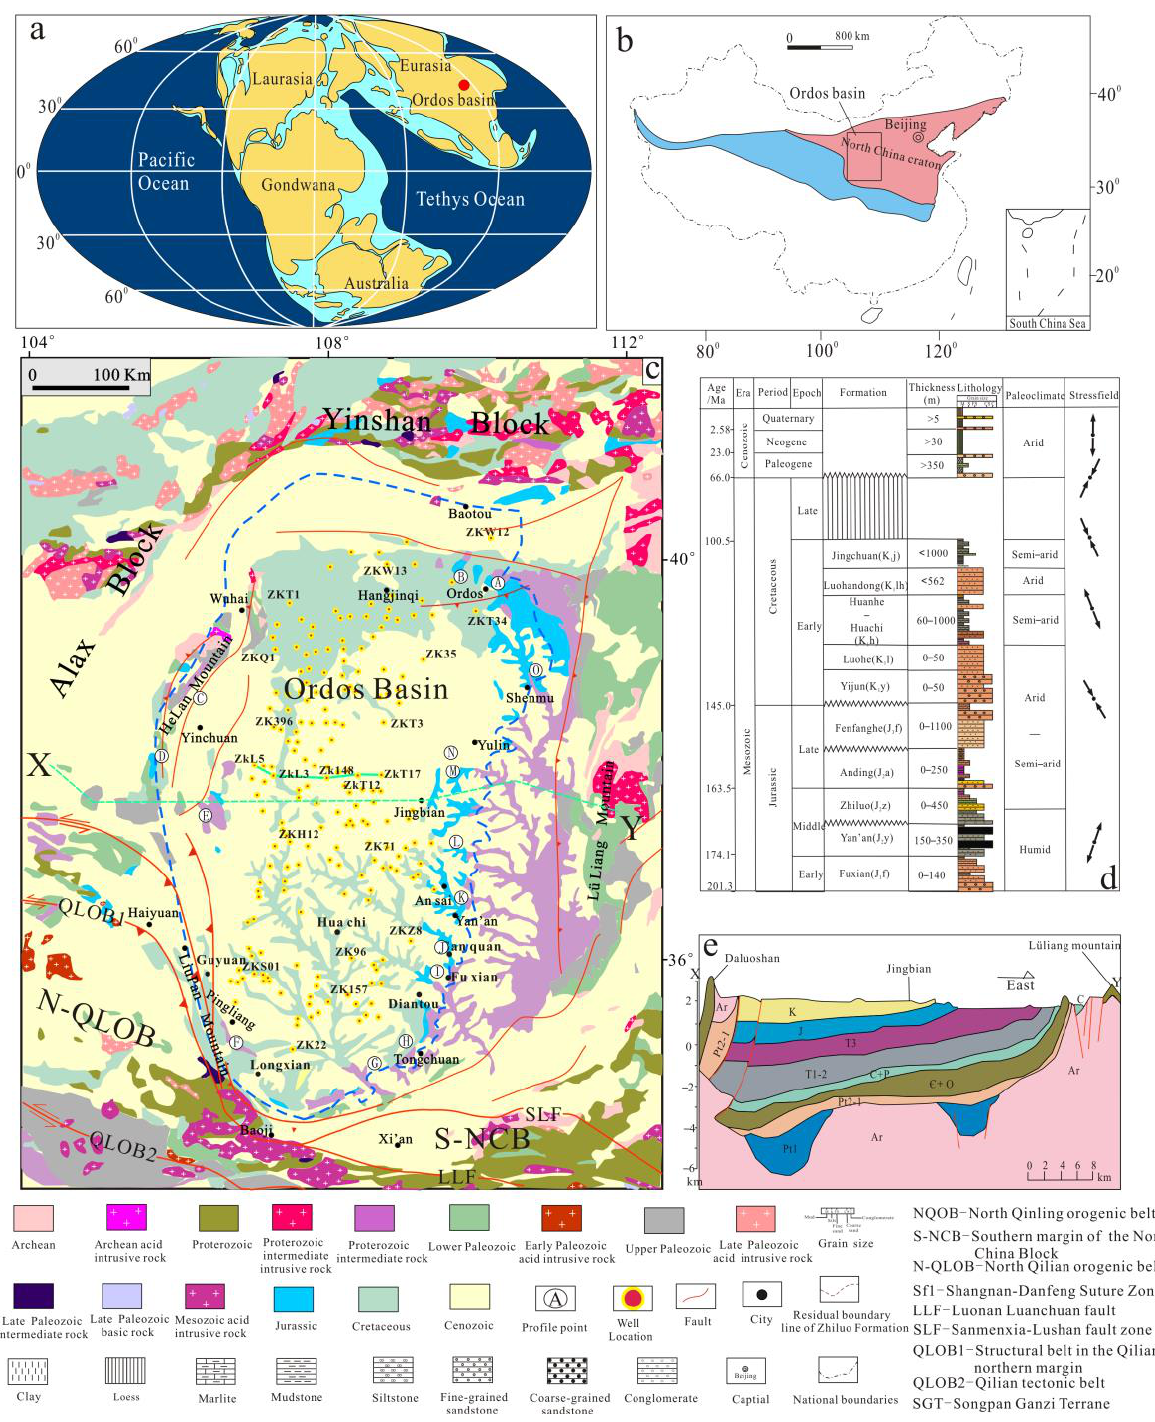
Figure 1. Location and geology maps of the Ordos Basin. ( a ) Middle Jurassic Bathonian (about 168 Ma) global Palaeogeographical map showing the position of Ordos Basin (modified after [50]). ( b ) The location of the Ordos Basin in China (modified after [51]). ( c ) Regional geological map of the Ordos Basin and its adjacent areas (modified after [52]). ( d ) Composite stratigraphic section of the Ordos Basin (modified after [53,54]). ( e ) East – West cross section XY of the Ordos Basin (modified after [55]).